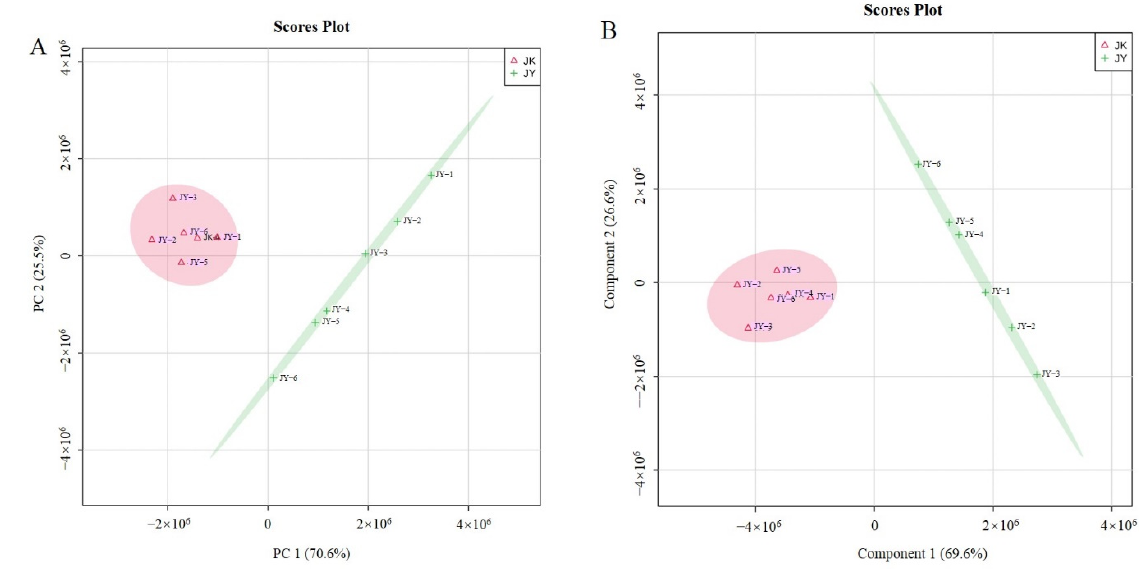
Figure 5. Multivariate cluster analysis of metabolite profiles of S. aureus : ( A ) PCA score plot; ( B ) PLS–DA score plot.